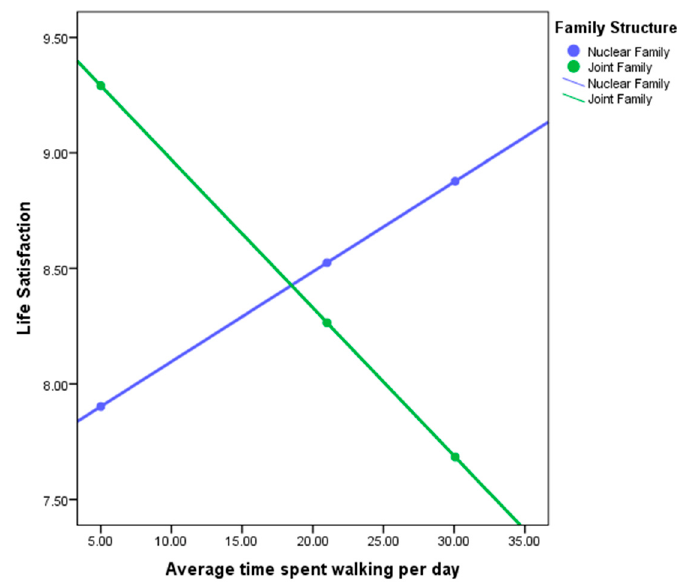
Figure 3. Life Satisfaction with Average time spent walking per day differentiated by multigenerational /Nuclear Family.